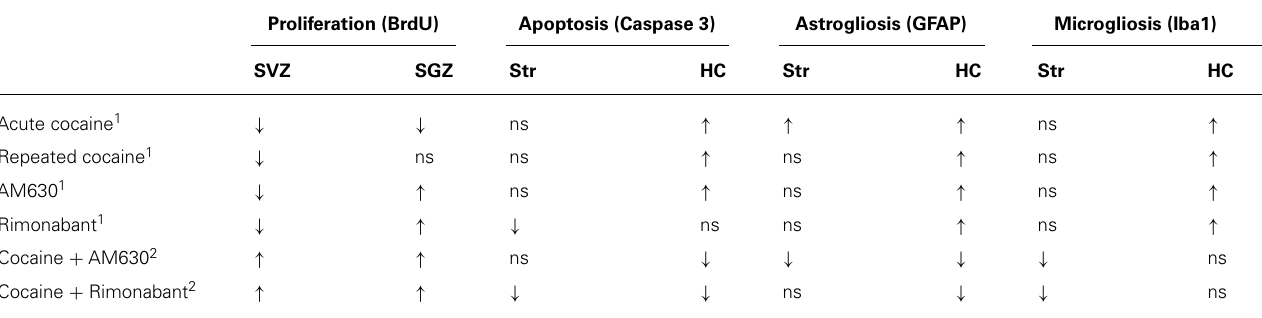
Table 1 | Summary of the main effects of acute and repeated administration and co-administration of cocaine with Rimonabant orAM630 on factors related to cell proliferation, apoptosis and gliosis. Proliferation